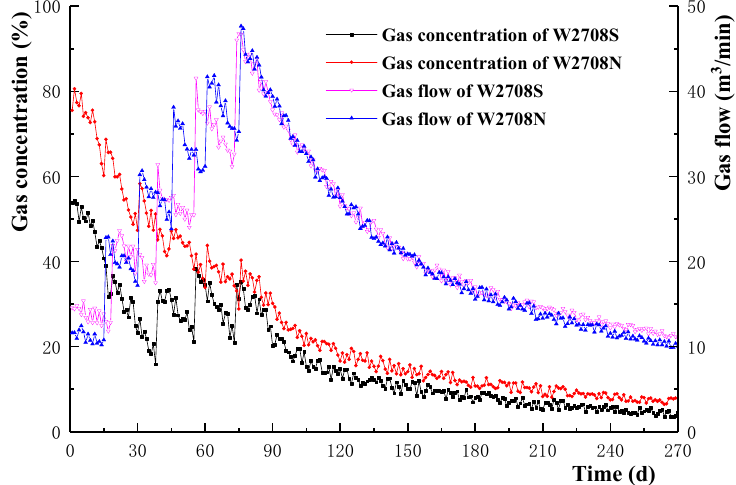
Figure 6. Concentration and flow curves of the extracted gas.